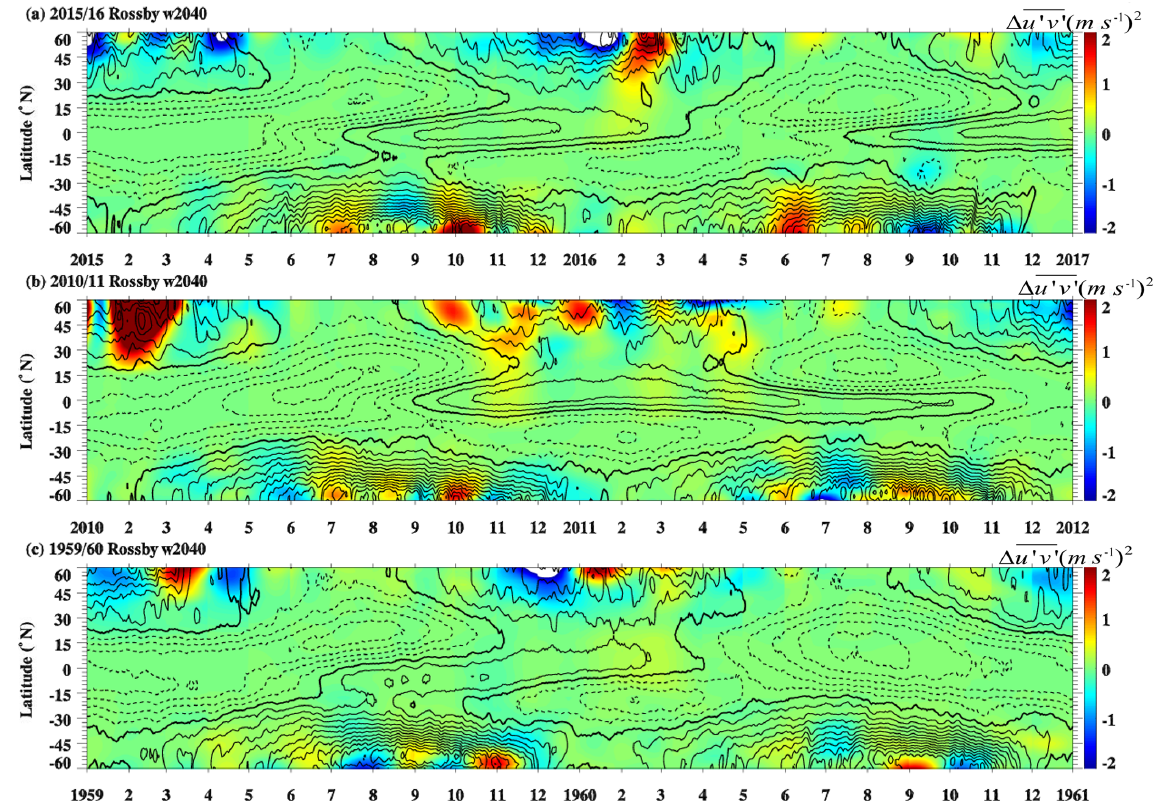
Figure 7. The latitude–time cross section of Rossby wave w2040 (with wavenumber 2) horizontal momentum flux anomalies in (a) 2015/2016, (b) 2010/2011, and (c) 1959/1960 at 40hPa. Color shadings denote the anomalies with respect to the monthly climatol- ogy. The zonal mean zonal wind is overlaid in black contours with contour interval of 5ms − 1 . The solid and dotted black contours denote westerly and easterly winds, respectively. The thick contours represent the zero wind